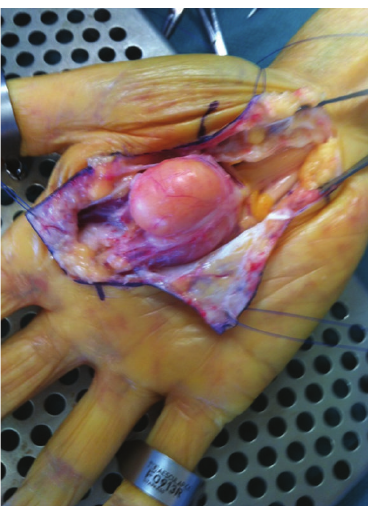
Figure 6: Peroperating view showing intimate relation between lipoma and nervous structures.